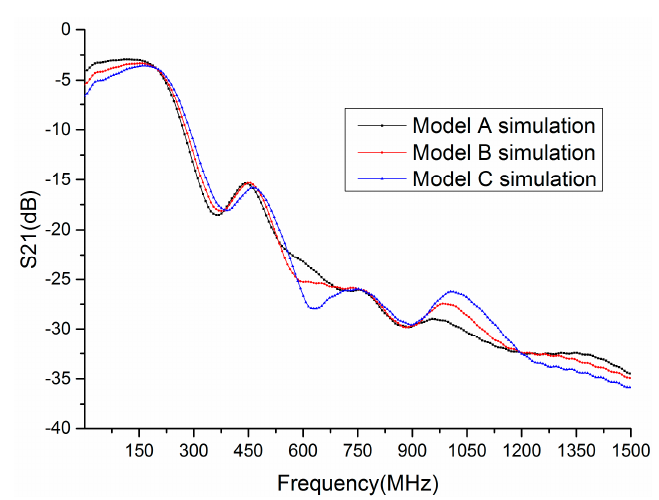
Figure 2. Transmission gain S21 of different models in FDTD simulations.